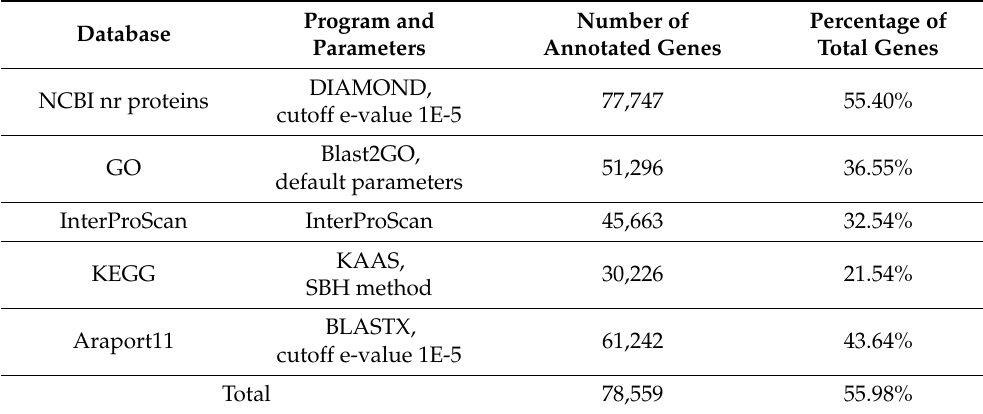
Table 2. Functional annotation of 140,355